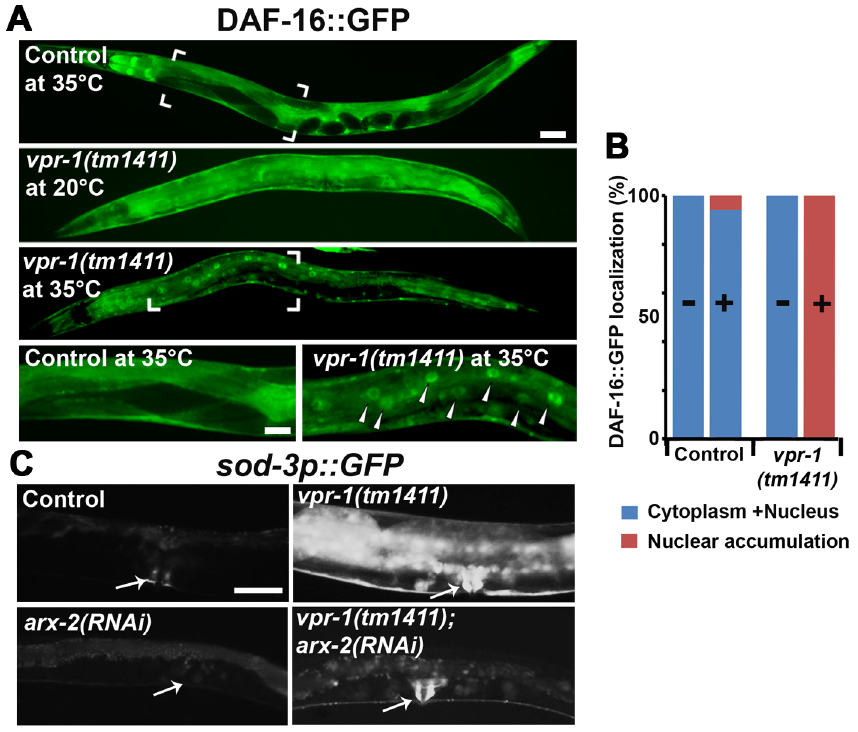
Figure 6. DAF-16 localization and activity in wild-type and mutant worms. (A) Transgenic strains expressing DAF-16::GFP under its endogenous promoter. Transgenic controls raised at 20 u C are similar to those raised at 20 u C then shifted to 35 u C for 30 minutes (see panel B for quantification). Close up images of boxed areas are shown. Anterior is to the left in all panels. Low magnification bar, 50 m m; high magnification bar, 25 m m. (B) Quantification of DAF-16::GFP localization in control (n=157) and vpr-1(tm1411) mutants (n=49). ( 2 ), incubation under normal growth condition; ( + ), incubation at 35 u C for 30 minutes. (C) Magnified images showing transgenic lines expressing GFP under the sod-3 promoter. arx-2 encodes Arp2. Arrows indicate vulva muscle region. Anterior is to the left in all panels. Bar, 50 m